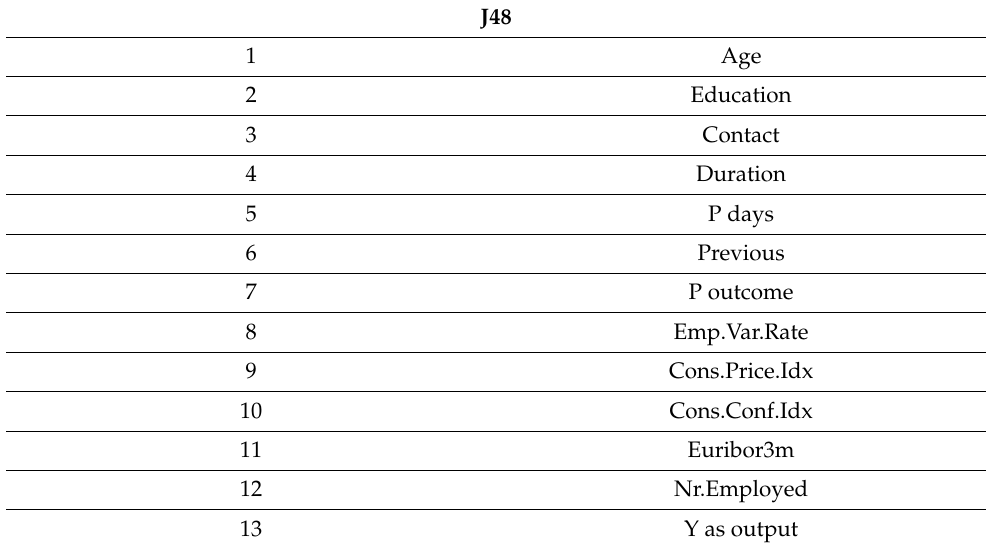
Table 3. Variables selected after using WappedSubsetEval to dimension reduction.